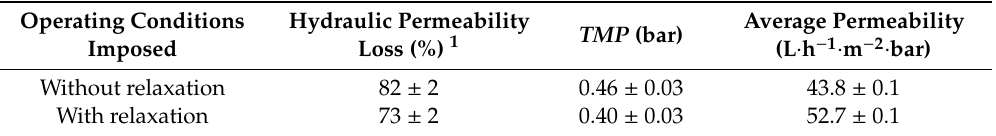
E ff ect of relaxation on the purification of the (diluted) arabinoxylans fraction by dia-ultrafiltration operated under controlled conditions of permeate flux J perm of 18.8 L · h − 1 · m − 2 , at 40 ◦ C and at a Reynolds number at the feed compartment of 184: hydraulic permeability loss